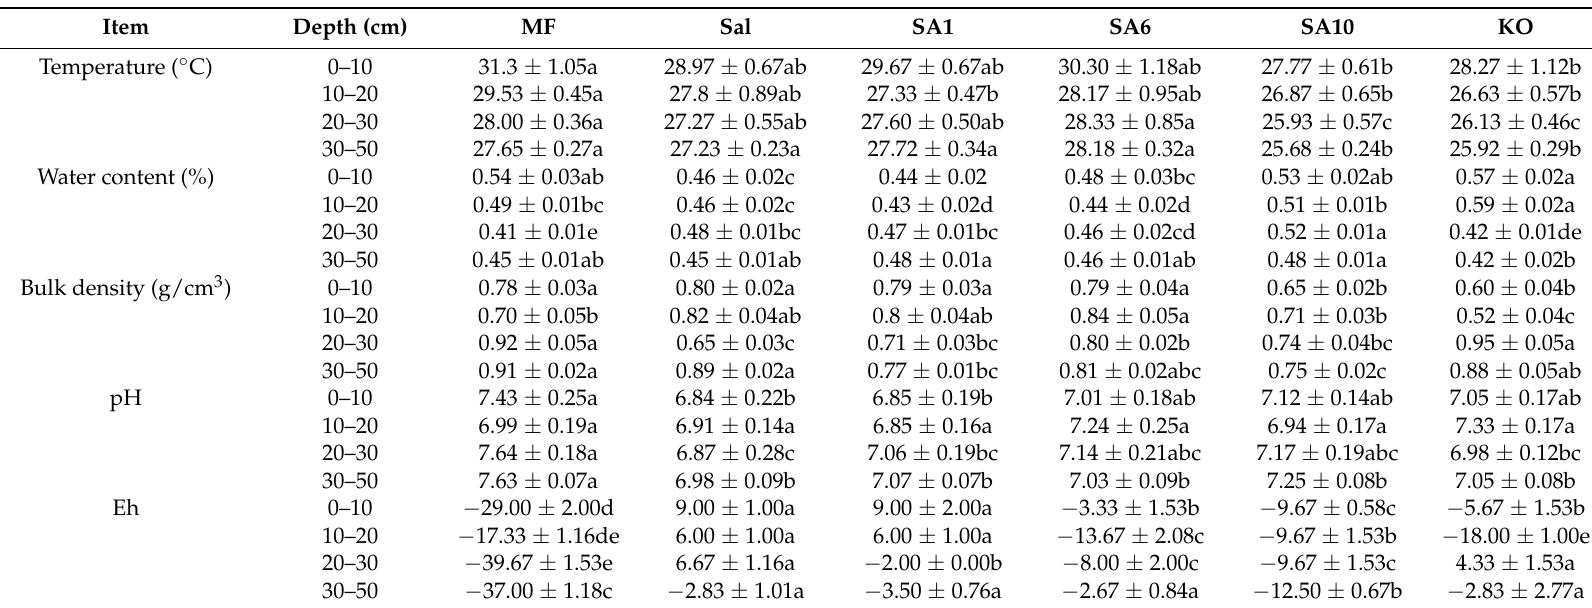
Table 1. Variation of soil physicochemical characteristics at different sites ( n = 3, Mean ± SE. Different letters indicate significant differences at the same soil layer among